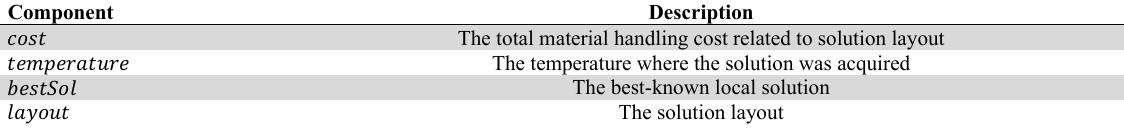
The components of the solution structure Component Description